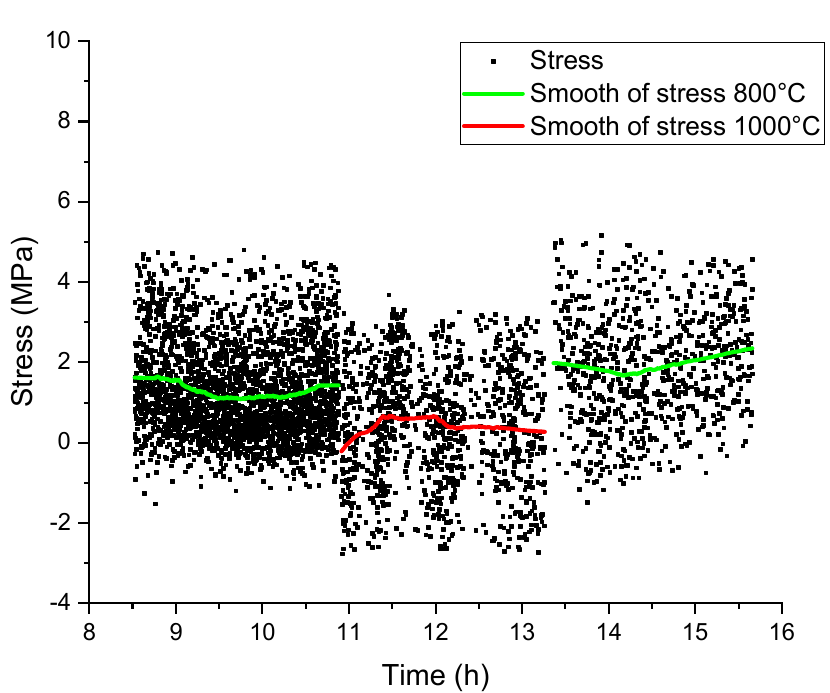
Figure 20. Stress-time curve in metal with the second correction method for R2.37.